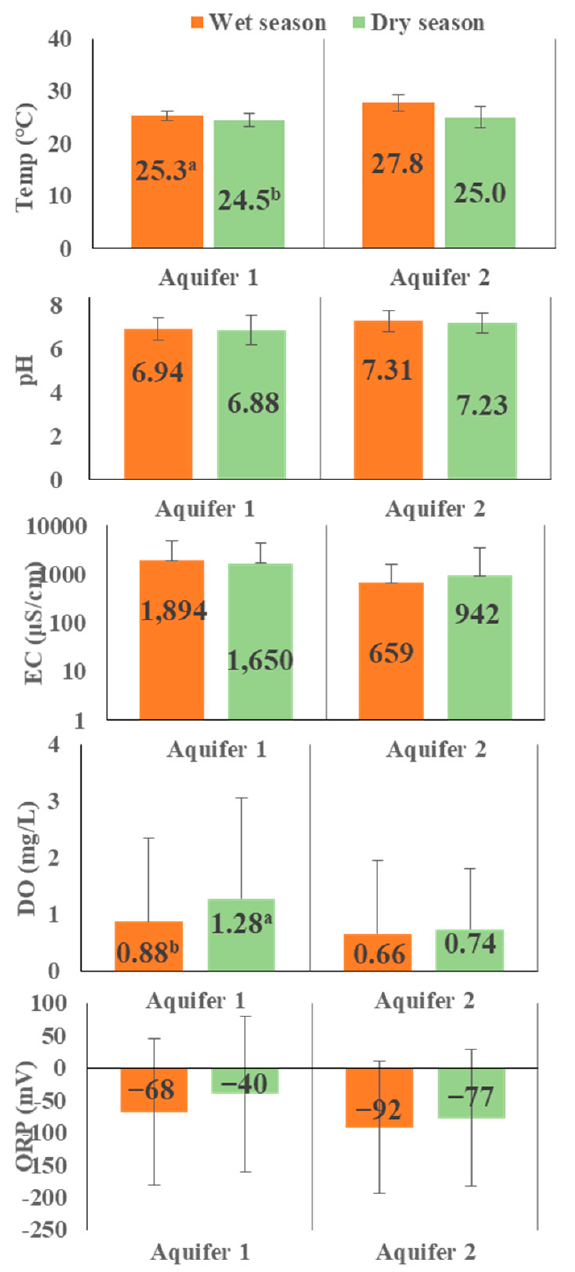
Figure 2. The mean values of the five on-site parameters and statistical results in Aquifer 1 and Aquifer 2 between the wet and dry seasons. (a superscript character after the mean value means that the water quality parameter has significant differences)